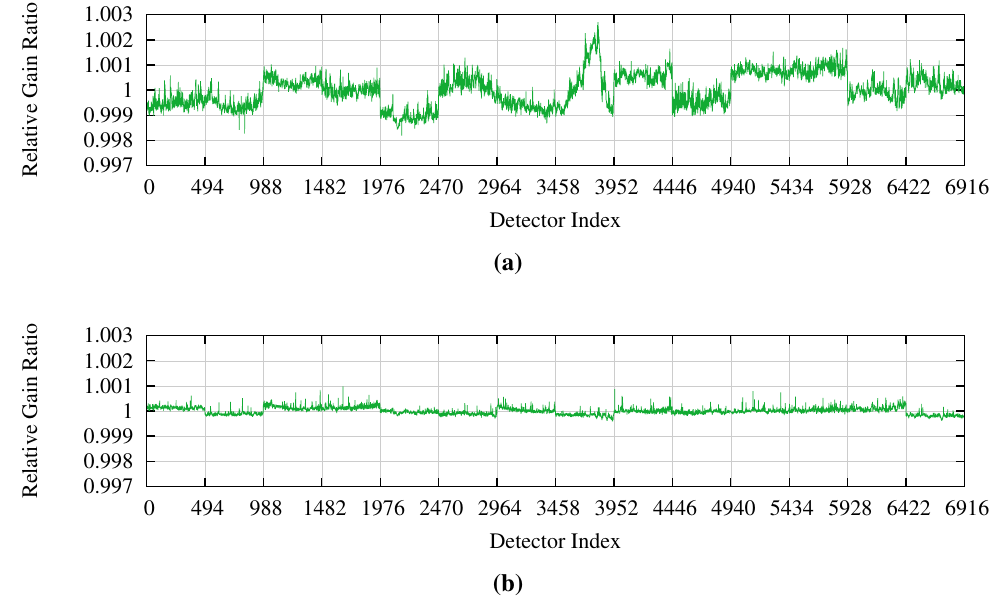
Figure 11. ( a ) The ratio between the coastal aerosol solar diffuser determined relative gains for the third and fourth quarters of 2013 where a safehold event occurred toward the end of the quarter causing the ratio to be larger than expected, up to 0.3%, which would be noticeable as stripes in Earth image data, if not corrected; ( b ) A more typical ratio between the fourth quarter of 2013 and first quarter of 2014 relative gains; in the absence of a safehold event, the relative gains are stable to within